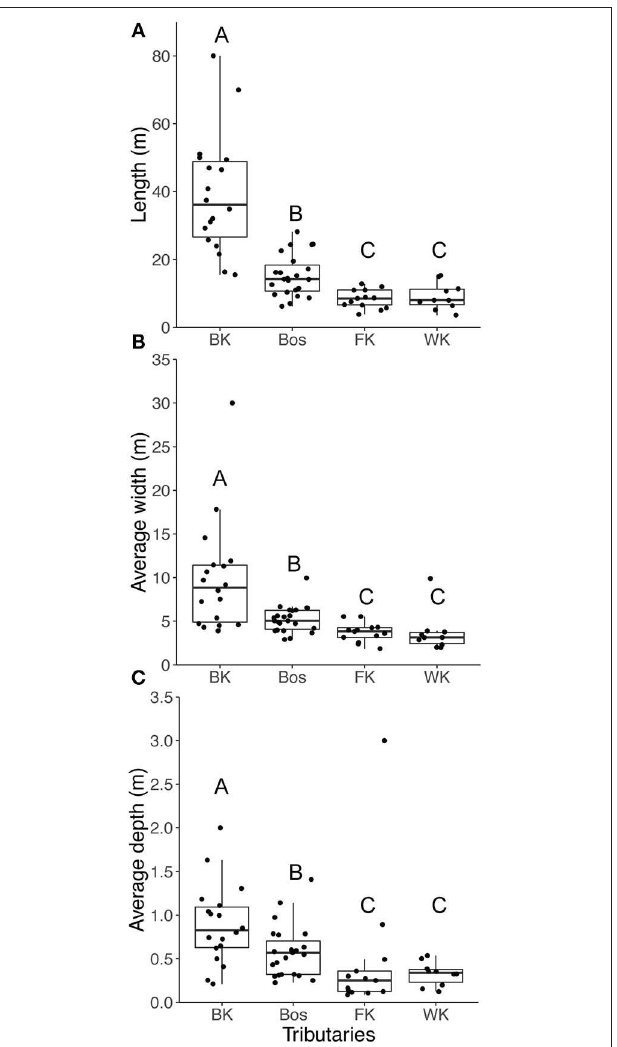
FIGURE 7 | Boxplots for the habitat characteristics for the pools in each of the tributaries, (A) length (m); (B) width (m); (C) depth (m). BK is the Blindekloof, Bos is the Bos river, FK is the Fernkloof, and WK is the Waterkloof. Different letters above boxplots represent significant differences ( p < 0.05) from the post-hoc Dunn’s